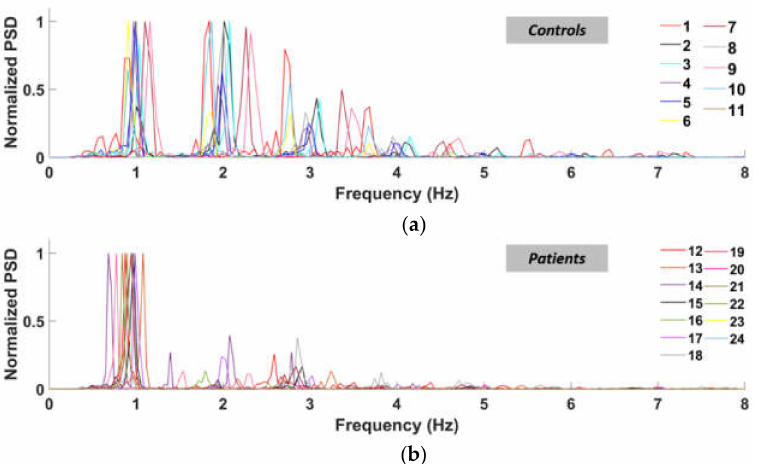
Figure 6. Normalized power spectral density curves of the left ankle (normal speed walking) for control subjects ( a ) and patients ( b